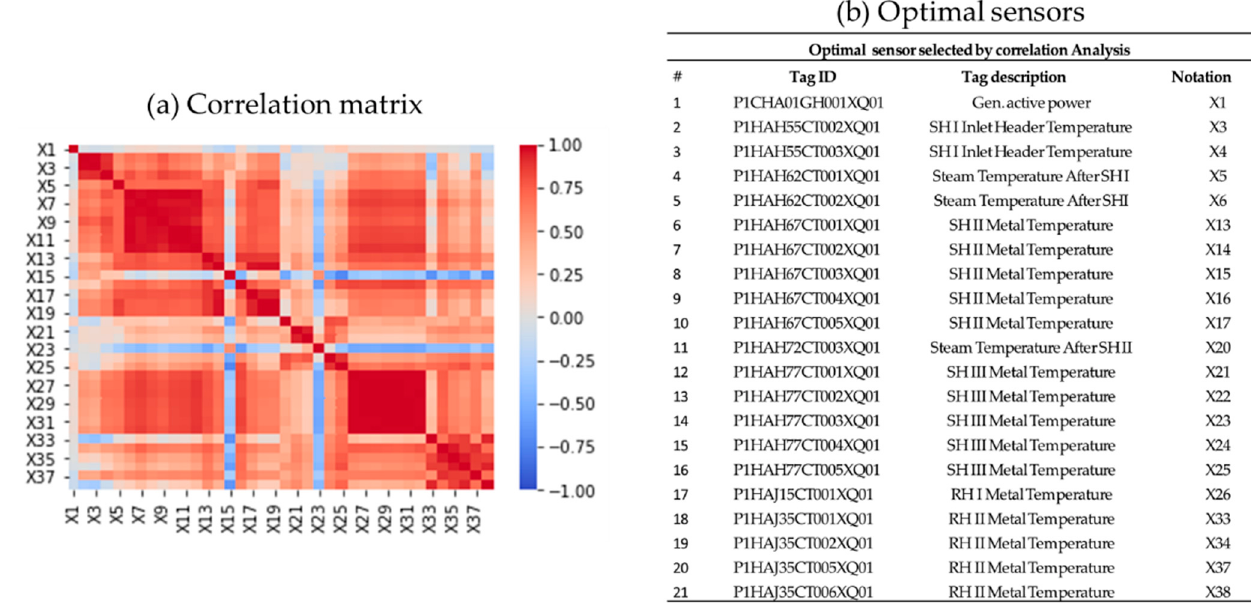
Figure 8. ( a ) Correlation between the input sensors; ( b ) the optimal sensors selected after correlation analysis.